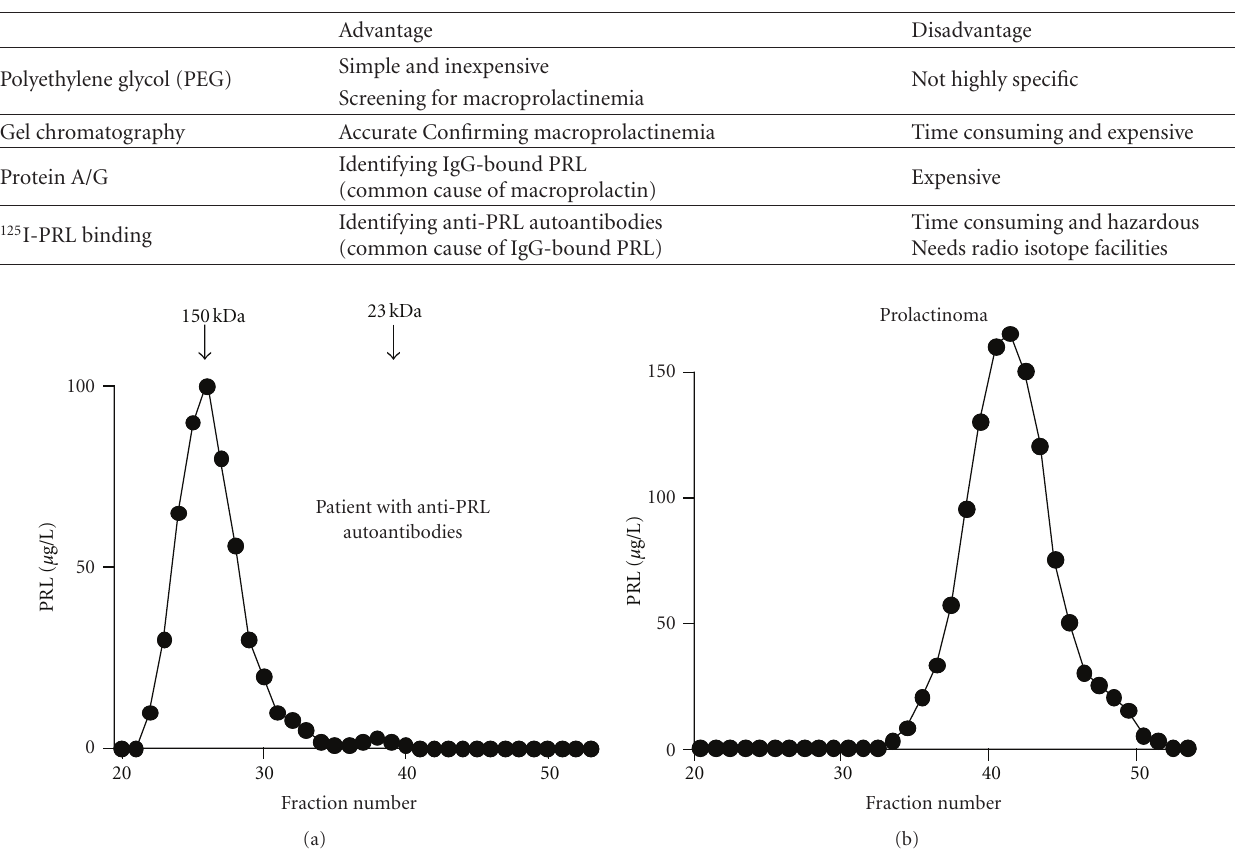
Table 1: Advantage and disadvantage of methods for the diagnosis of macroprolactinemia.